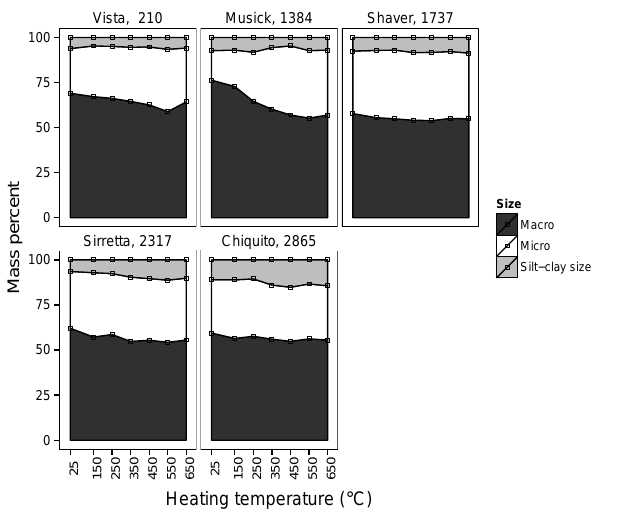
Figure 5. Weight fraction of aggregate sizes: macro (2–0.25mm), micro (0.25–0.053mm) and silt-clay ( < 0.053mm) sizes.